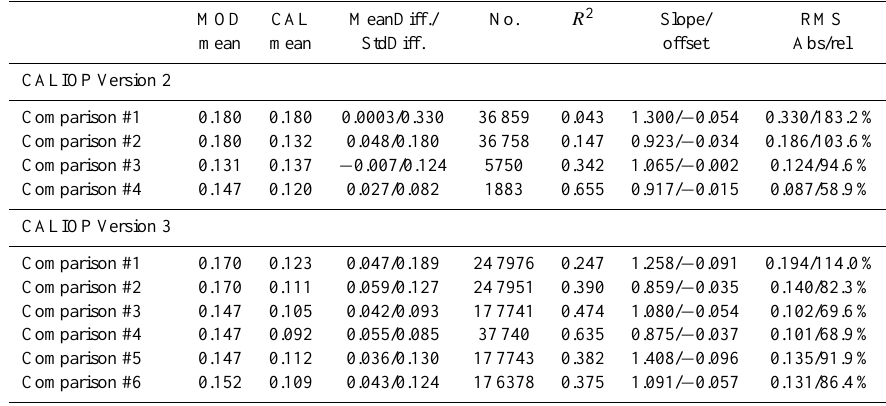
Table 2. MODIS vs. CALIOP AOD532, January 2007, over-ocean. MOD CAL MeanDiff./ No. R 2 Slope/ mean